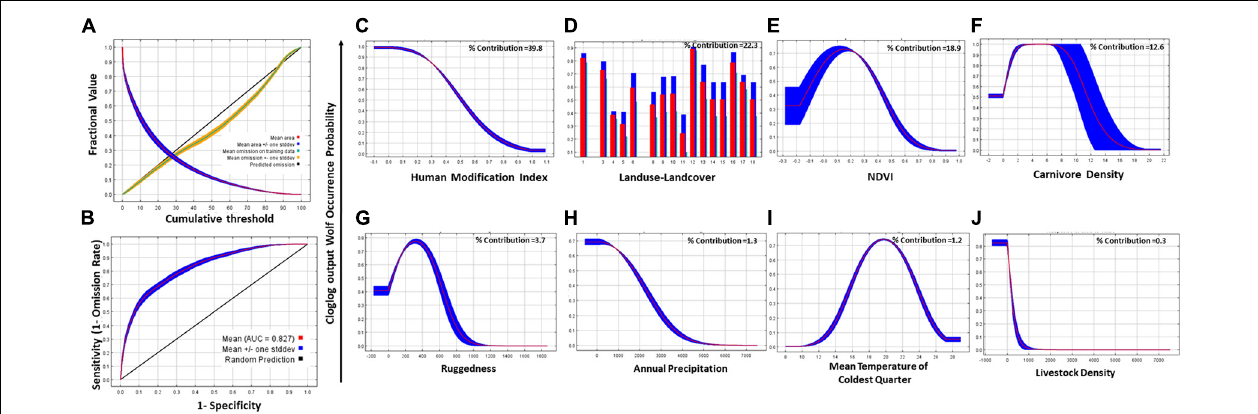
FIGURE 2 | Response curves of wolf occurrence with eco-geographical variables, their contributions, and model fit assessment obtained from 100 bootstrap runs of the best MaxEnt model. (A) Variation in the omission of model data and predicted area with increasing MaxEnt cumulative threshold values. (B) Receiver operating curve of test and training data. (D) Land use land cover classes were (1) arid scrub, (3) grassland, (4) agriculture, (5) settlement, (6) open, (8) water, (9) riparian, (10) evergreen open, (11) evergreen broadleaf, (12) deciduous broadleaf, (13) deciduous open, (14) mixed open, (15) evergreen broadleaf open, (16) deciduous broadleaf open, (17) scrub, and (18) coastal marsh. (E) Normalized Difference Vegetation Index (NDVI). (F) Carnivore density (density of tigers and lions) across their range in